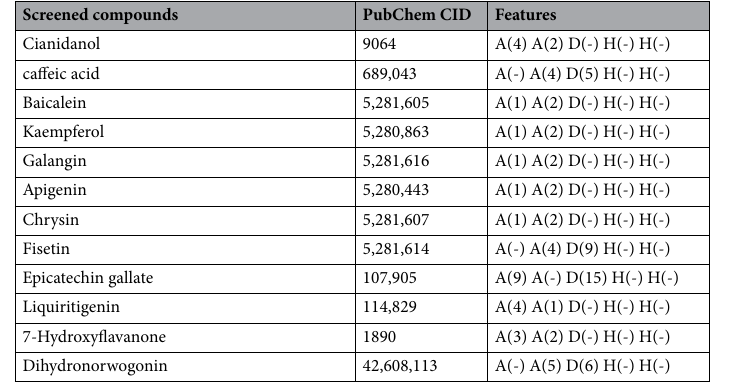
Table 2. Screened compounds based on E-pharmacophore feature mapping. A hydrogen acceptor, D hydrogen donor, and H hydrophobicity.